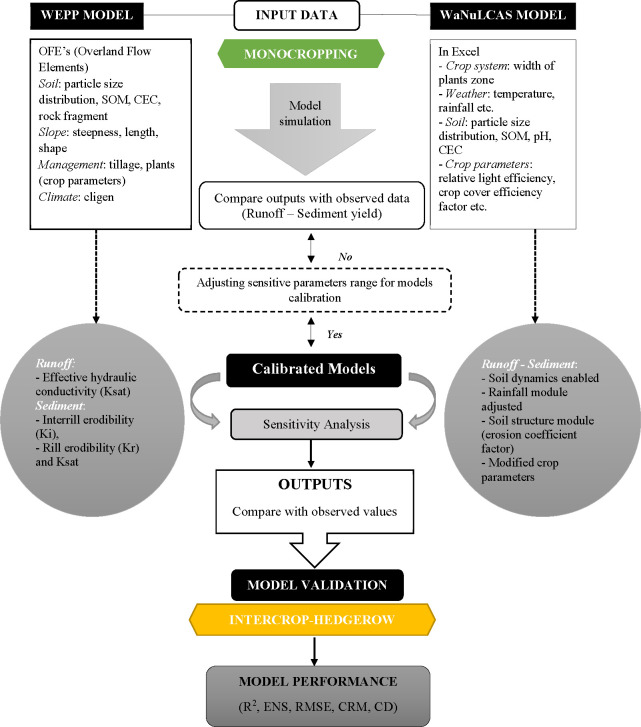
Protocol for calibration and validation of the WEPP and the WaNuLCAS.